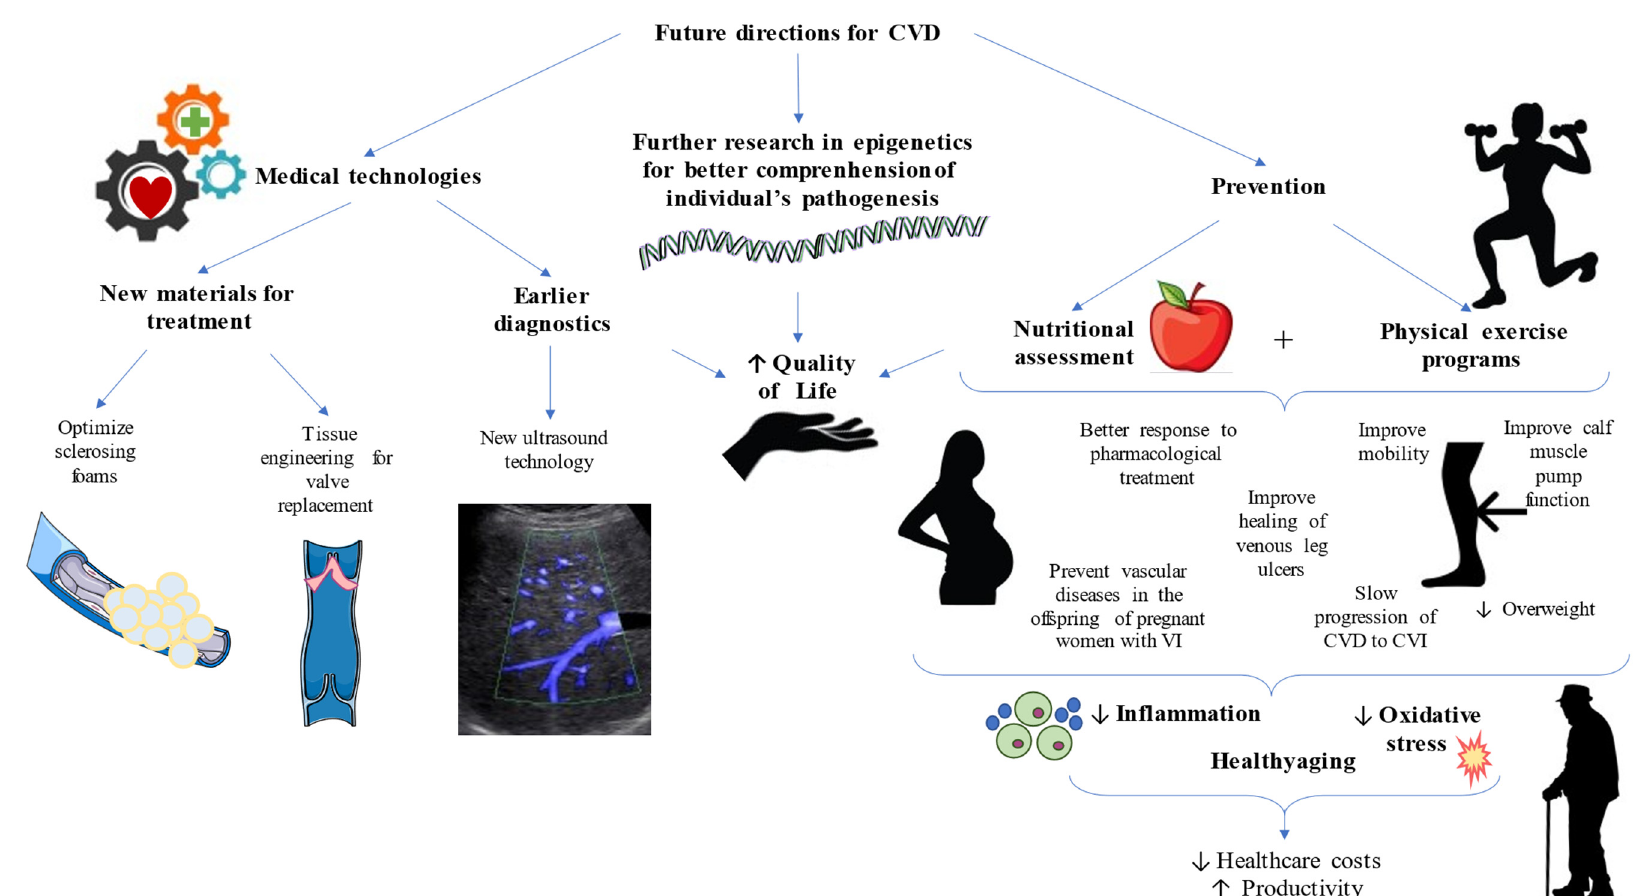
Figure 5. Future directions for CVD. The emergence of novel therapeutic or diagnostic methods are playing a key role in the clinical management of the patients with CVD. However, it is equally important to “deep” on the epigenetic and individual mechanisms, to allow for better comprehension of the disease, opening the possibilities of novel translational approaches. Perhaps one of the most disregarded and important factors are encompassed around prevention. In this sense, nutritional assessment and physical exercise could be powerful tools in the handle of patients affected by CVD, as they might favorably regulate clinical signs, pathophysiological mechanisms, such as inflammation or oxidative stress, and even psychological variables. Overall, these points will be crucial to improve the QOL of the patients, which might be particularly vulnerable by other variables (e.g., pregnant women or elder people).